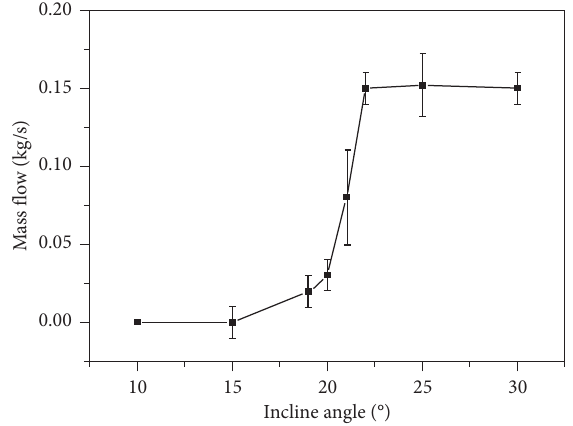
Figure 3: Variation of flow rate with an inclination